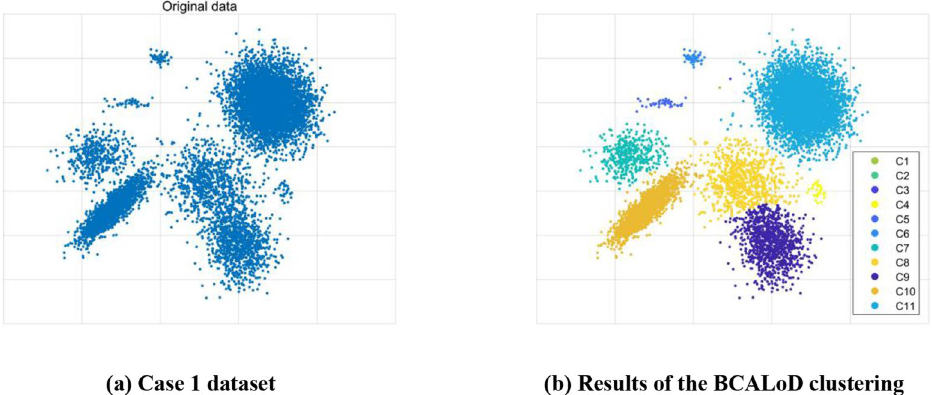
Figure 2. Cluster analysis of 2D Gaussian mixture distribution datasets. ( a ) 2D Gaussian mixture distribution datasets. ( b ) Clustering results of the BCALoD